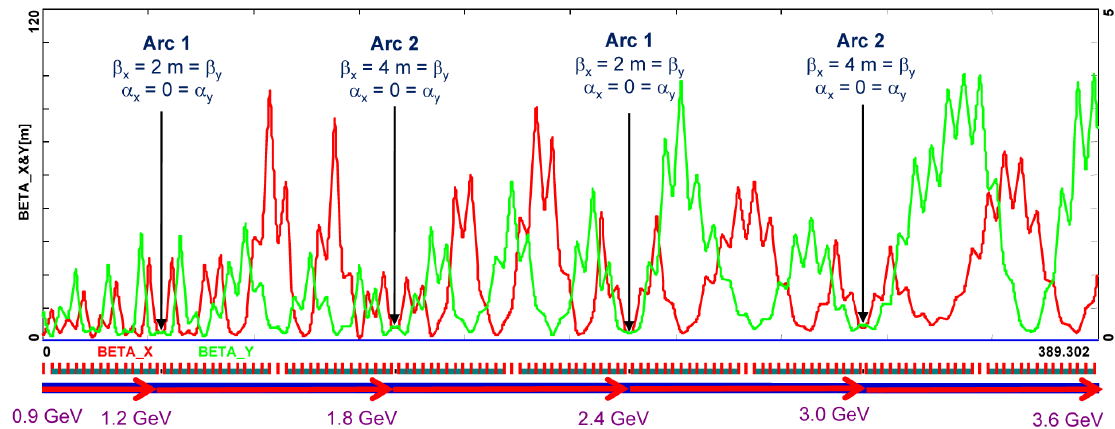
FIG. 9. Linac optics matched to both arcs for all passes simultaneously. The arrows indicate arc locations.